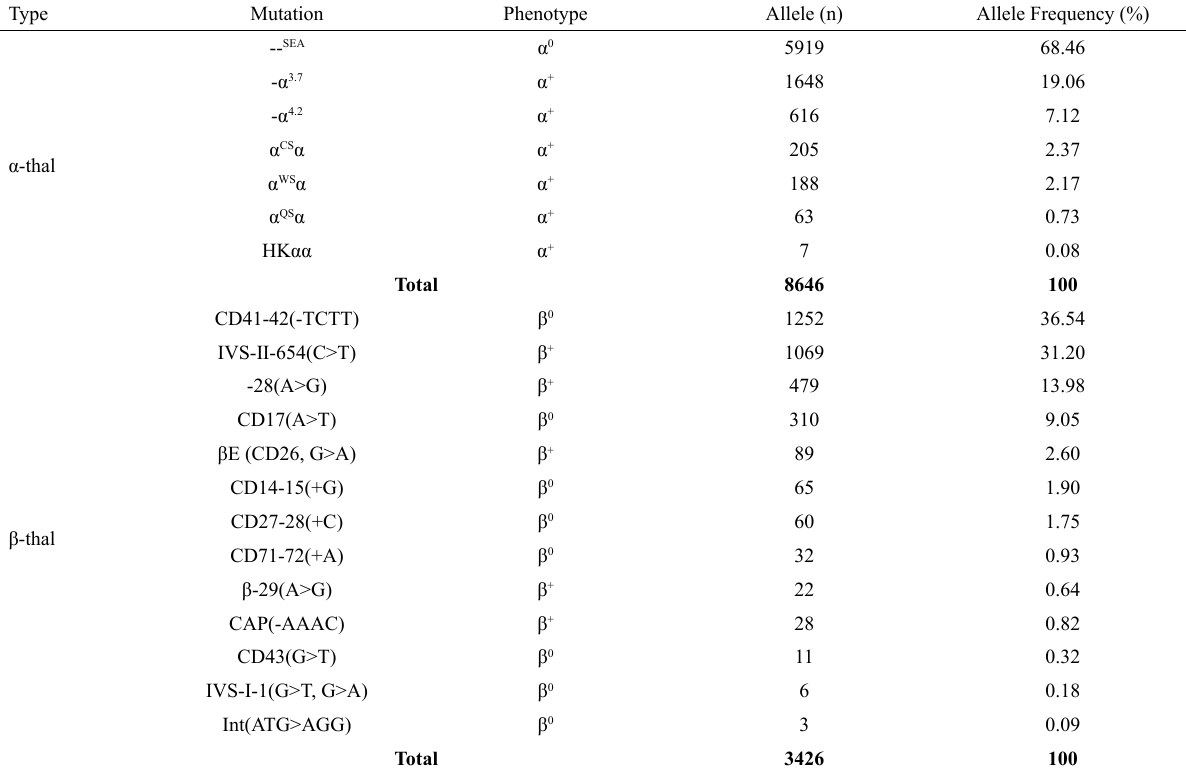
Table 4 – Allele frequencies of α-thal/β-thal mutations in Heyuan.